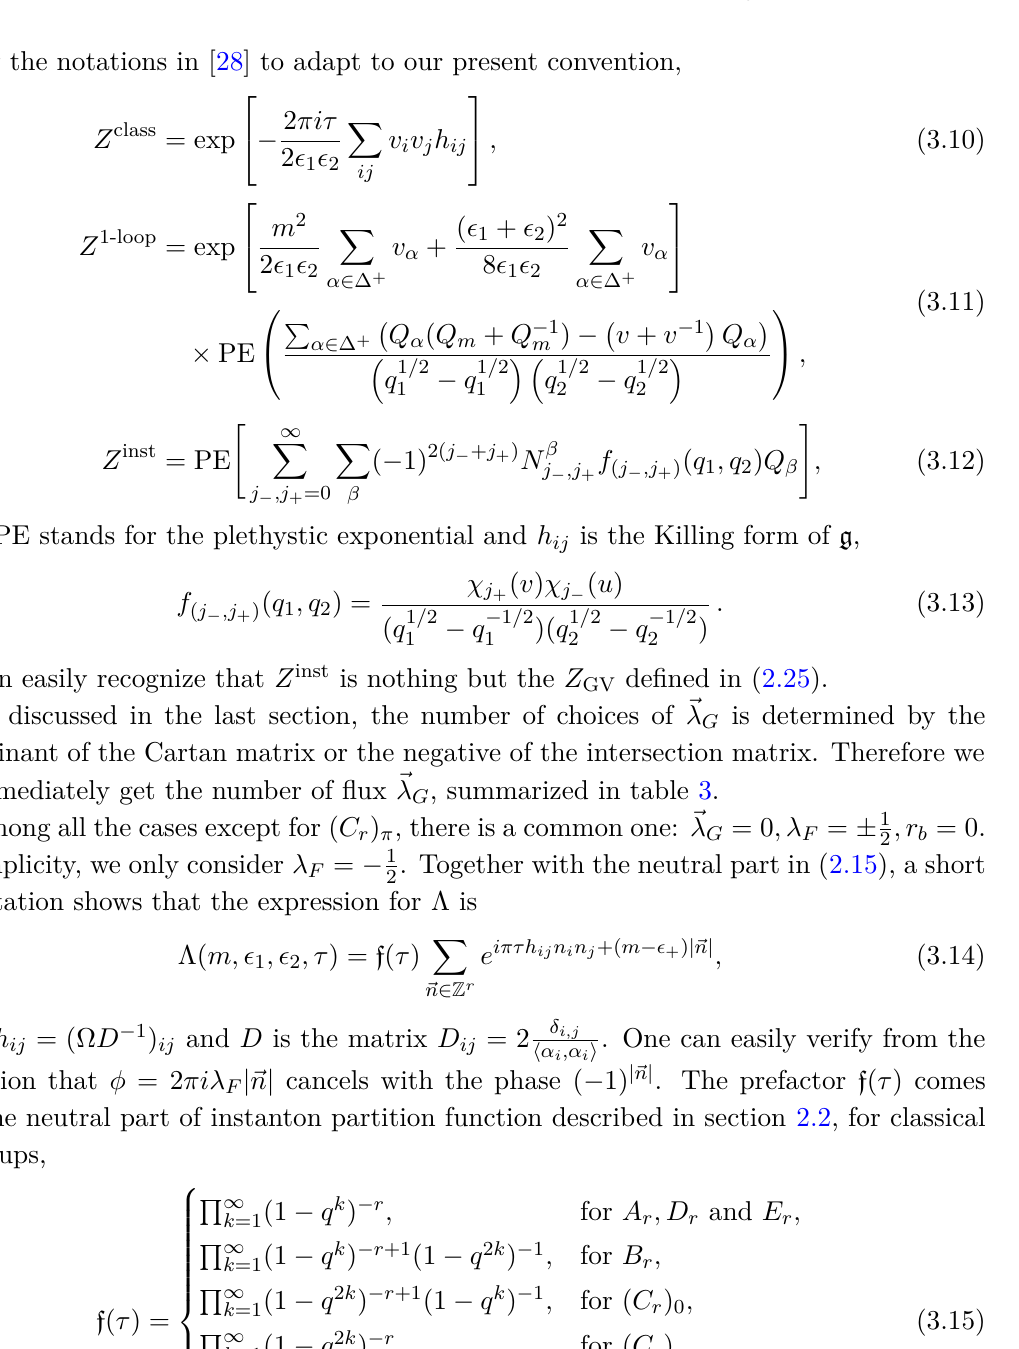
Table 3 . The number of possible fluxes ~λ G for simple Lie